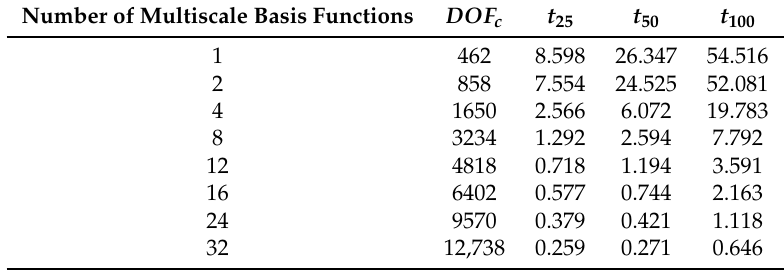
Figure 14. Numerical results for Test 3.NBC . Solutions p and p ms for the final time. Left : Fine-scale solution DOF f = 43,524. Right : Multiscale solution using 32 basis functions DOF c = 12,738. Table 8. Numerical results for Test 3.NBC . Relative L 2 error (%) for different numbers of multiscale basis